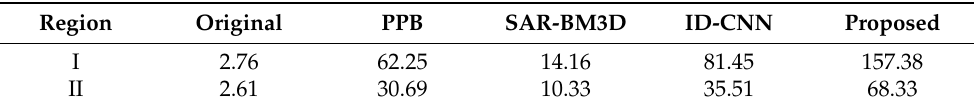
Table 5. The estimated ENL results for the Flevoland SAR image.